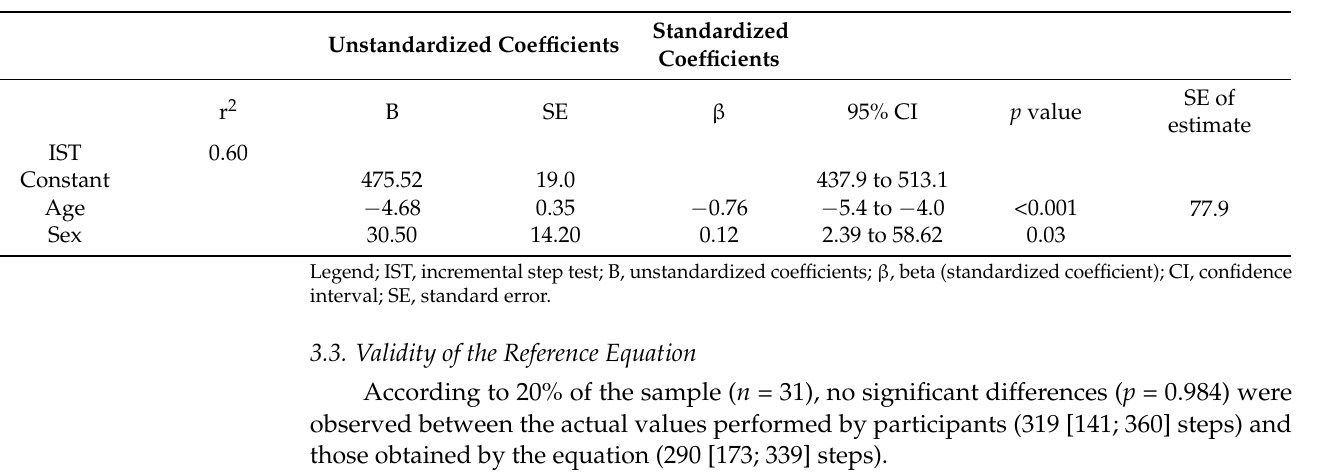
Table 3. Multiple linear regression analysis with the incremental step